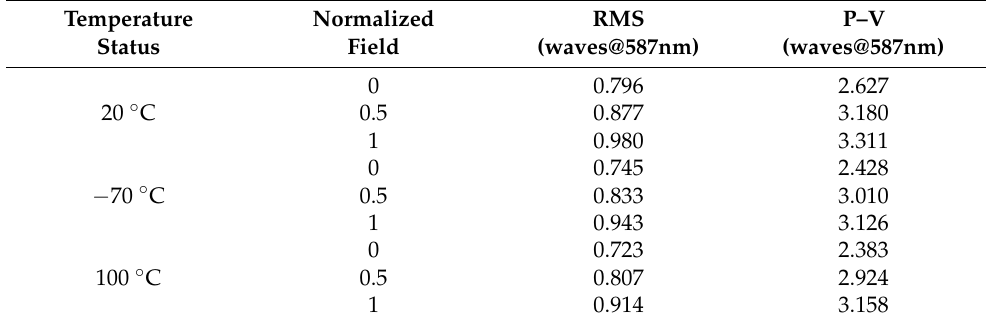
Figure 1. Layout of the athermal visible lens without considering thermal-induced surface deformation. Table 3. Wavefront analysis results of the passive athermal visible lens with different